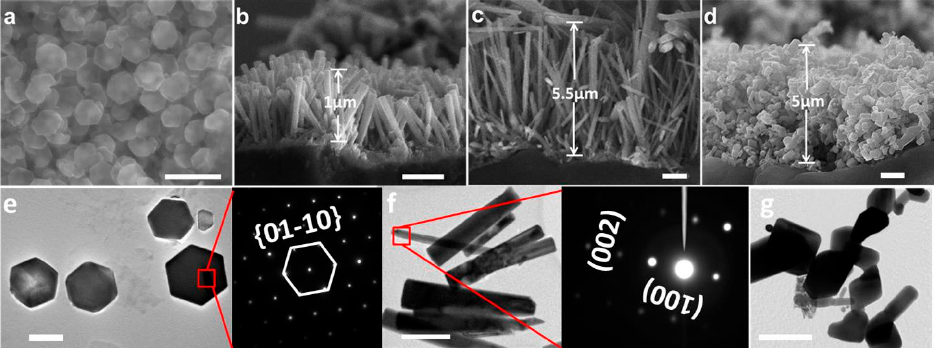
Figure 7. Electron microscopy characterization of ZnO nano ‐ arrays with different shapes and sizes. SEM images of ( a ) nanoplates; ( b ) 1 ‐μ m nanowire; ( c ) 5 ‐μ m nanowire; ( d ) wash ‐ coated ZnO powders. TEM images of ( e ) ZnO nanoplate with inset electron diffraction pattern; ( f ) ZnO nanowires with inset electron diffraction pattern; ( g ) ZnO powders. Reprinted with permission from [36], Copyright Elsevier, 2013.